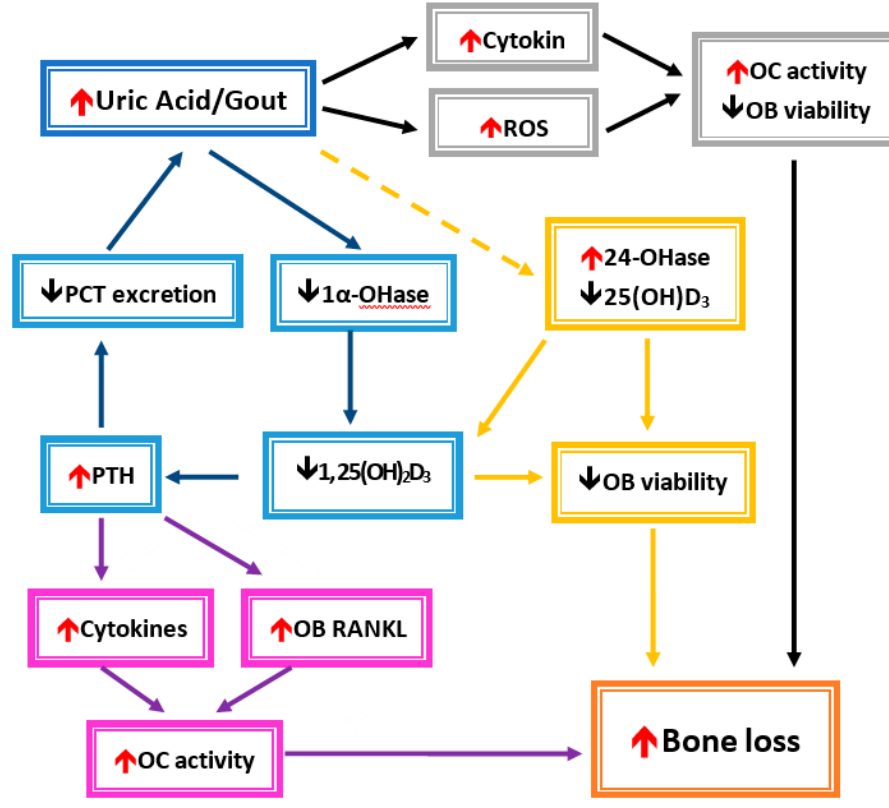
Figure 3. Conceivable mechanisms of hyperuricemia-/gout-induced bone loss. In the gray frames, UA or gout induces the circulation of cytokines and reactive oxygen species (ROS). A decrease in osteoblast cells (OB) and enhanced osteoclast cells (OC) were affected, which then leads to bone